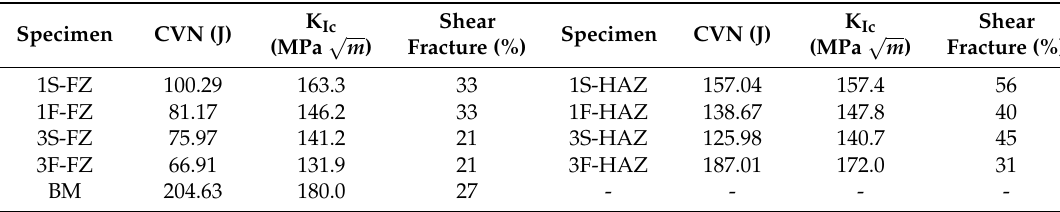
Table 10. Results of Charpy impact energy tests (average